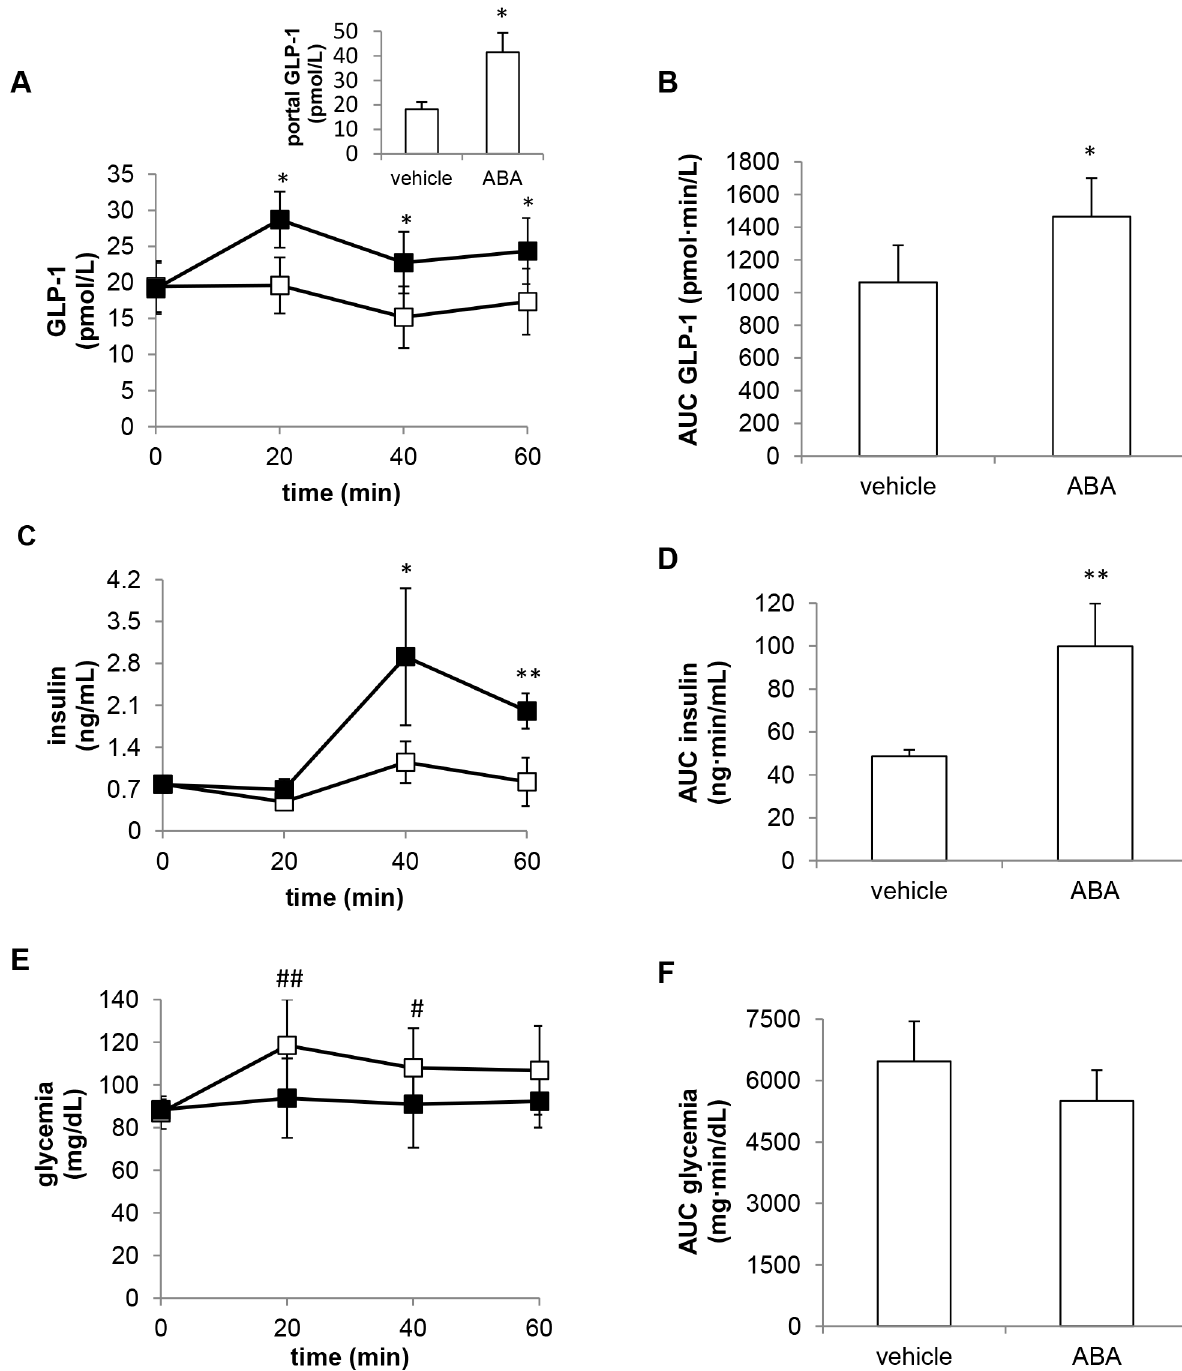
Fig 3. Effect of oral ABA on plasma GLP-1, insulin and glucose levels in rats. ABA (50 mg/Kg, black squares) or vehicle alone (open squares) were orally administered to rats pre-treated with Sitagliptin (6 animals per experimental group) and blood samples were collected at 0, 20, 40 and 60 min to evaluate plasma GLP-1 (A), insulin (C) and glucose (E). The AUC corresponding to the curves of GLP-1 (B), insulin (D) and glycemia (F) were calculated. Inset to panel A: blood samples were collected from the portal vein of rats not pre-treated with Sitagliptin, 10 min after ABA or vehicle administration and GLP- 1 levels were evaluated (n = 5 rats per group). * , p < 0.05 and ** , p < 0.01 compared with the corresponding value in vehicle-treated animals; #, p < 0.05 and ##, p < 0.01 compared with time zero.